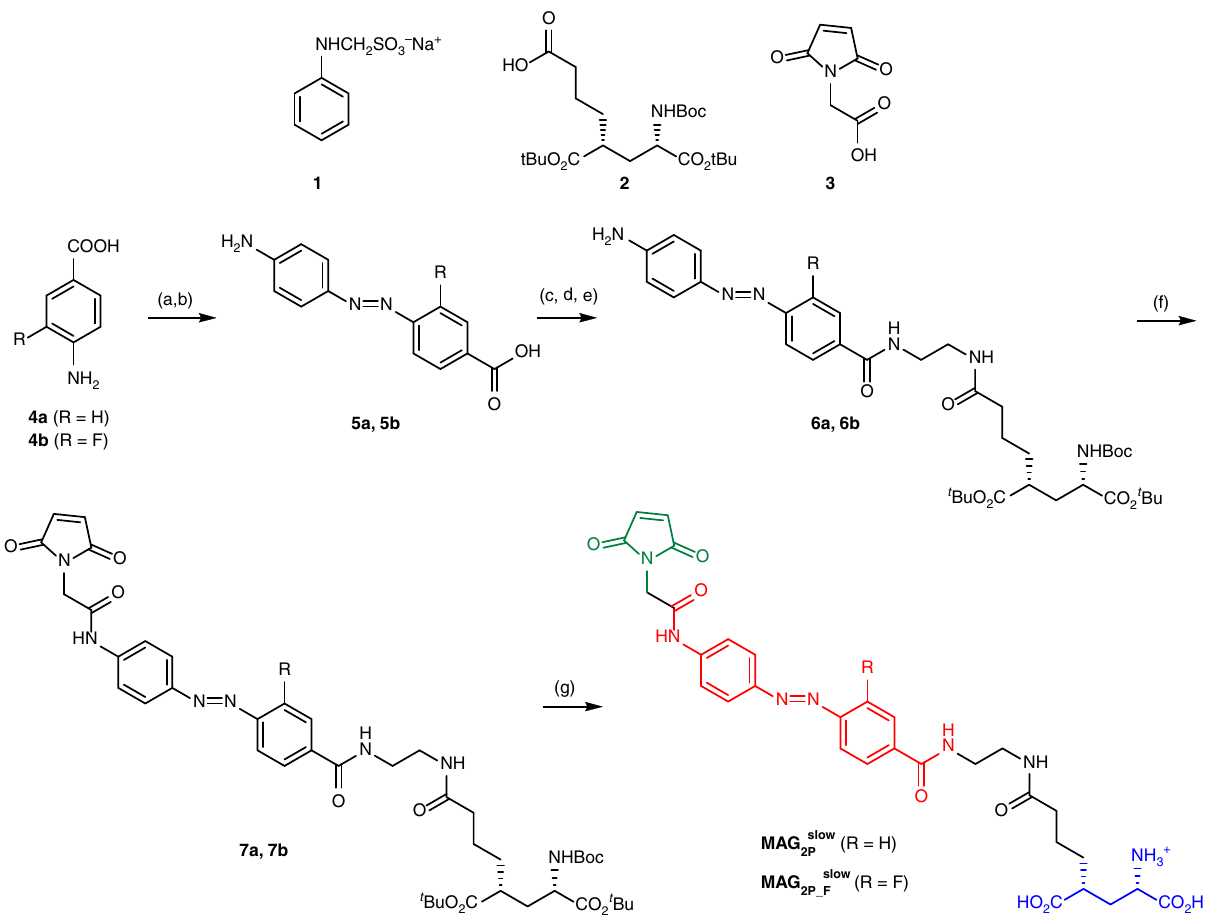
and MAG slow . Reagents and conditions: (a) 5.5 M HCl, NaNO 2 ; (b) (i) 1 , 0.86 M NaOAc; (ii) 1 M NaOH; (iii) 5.5 M HCl (38%, Fig. 2 Synthesis of MAG slow 2P 2P (cid:1) F over the two steps, for 5a , 47% for 5b ); (c) tert -butyl (2-aminoethyl)carbamate, N -ethyl- N ′ -(3-dimethyldiaminopropyl)-carbodiimide HCl (EDCI), 1- hydroxybenzotriazole hydrate (HOBt), diisopropylethylamine (DIPEA), THF; (d) 37% HCl, MeOH; (e) 2 , EDCI, HOBt, DIPEA, THF (47%, over the three steps, for 6a , 49% for 6b ); (f) (i) 3 , ClCOCOCl, CH 2 Cl 2 , DMF; (ii) DIPEA, THF (86% for 7a , 84% for 7b ); (g) tri fl uoroacetic acid (TFA), CH 2 Cl 2 (80% for , quantitative yield for MAG slow MAG slow 2P (cid:1) F 2P (cid:1) F